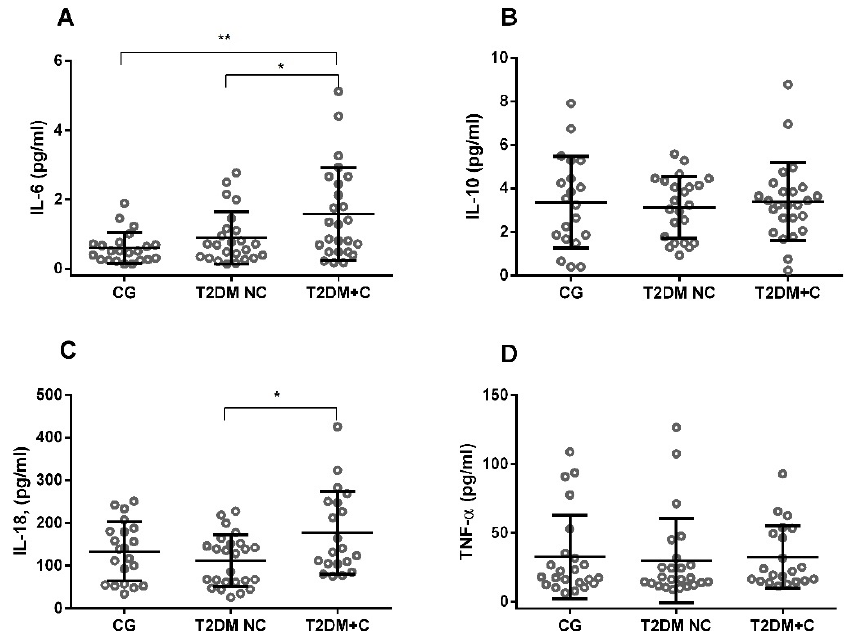
Figure 5. The concentration of pro- (IL-6, IL-18, and TNF- α ) and anti-inflammatory cytokines (IL-10) in plasma samples from diabetic and control groups. ( A ) IL-6; ( B ) IL-10; ( C ) IL-18; and ( D ) TNF- α were assessed. Comparisons between groups are indicated in the graphs. Data are presented as mean ± SEM. * p < 0.05, ** p < 0.01, vs. control.